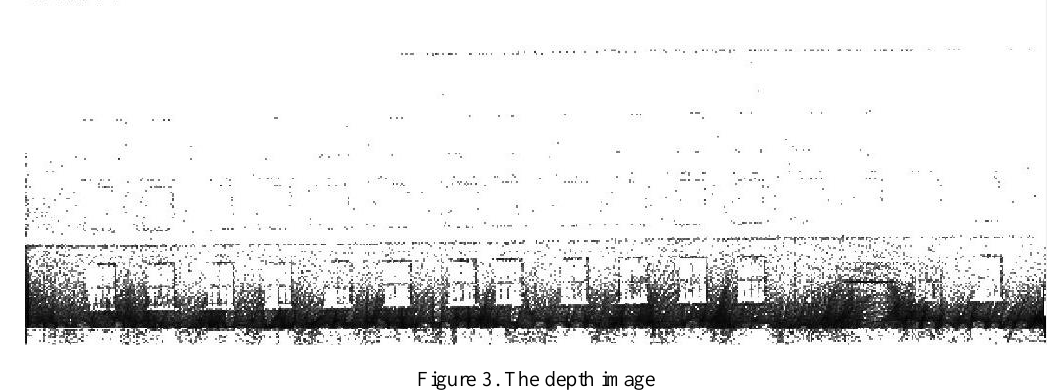
Figure 3. The depth image